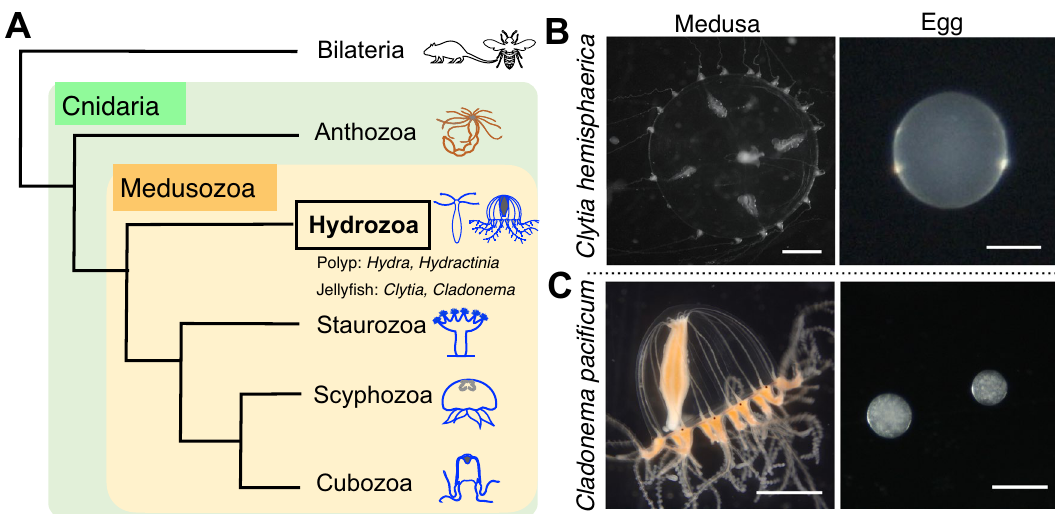
Figure 1. The hydrozoan jellyfish Clytia hemisphaerica and Cladonema pacificum . ( A ) Cladogram depicting the phylogenetic position of cnidarian jellyfish. As the sister group of Bilateria, the phylum Cnidaria is divided into two clades, Anthozoa and Medusozoa, which consists of four classes: Hydrozoa, Staurozoa, Scyphozoa, and Cubozoa. Hydrozoa includes polyp type animals without a medusa stage (e.g. Hydra and Hydractinia ) and jellyfish that have both polyp and medusa stages (e.g. Clytia and Cladonema ). ( B , C ) Photos of an adult medusa and the eggs of Clytia hemisphaerica ( B ) and Cladonema pacificum ( C ). Scale bars: 1 mm for medusae; 100 µm for